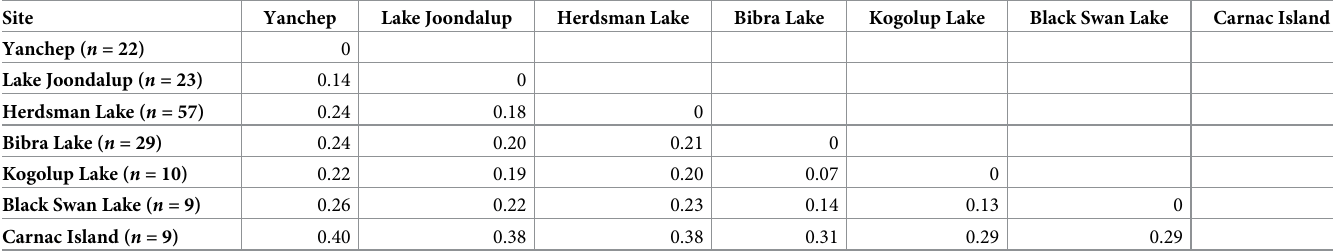
Table 1. Pairwise values of population genomic differentiation ( G 00 ST ) of Notechis scutatus occidentalis around Perth, Western Australia.